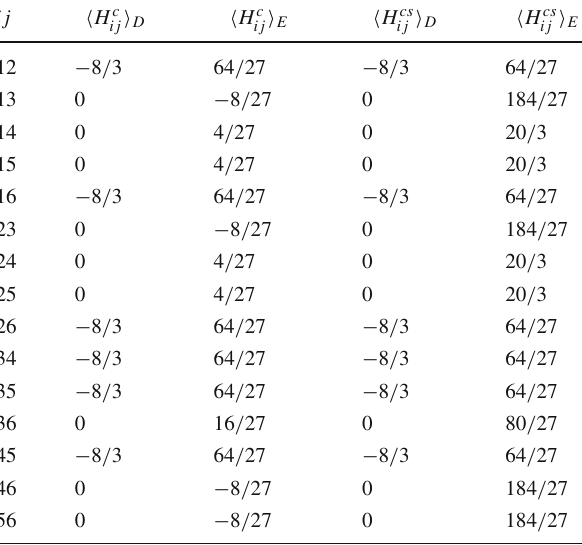
Table12 Thecrossmatrixelementsinspin-flavor-color-isospinspaces of the color-singlet and hidden-color channels for the Ω ccb Ω bbc system with J P = 0